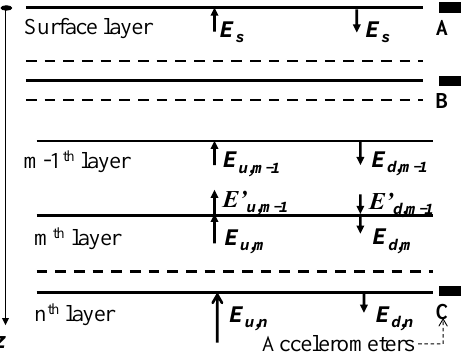
Figure 9. Level ground idealized by a set of horizontal soil layers with vertical array seismometers. Nine earthquakes (Kobe EQ. and EQ1 to EQ8) and 30 vertical array sites used here are listed in Table 1 with associated parameters. They are of the moment magnitude M W = 6.6 to 7.9 or JMA magnitude M J = 6.7 to 8.0 (magnitude in Japan Meteorological Agency scale, similar to Richter scale). A total number of 30 vertical array sites was selected for the nine earthquakes with focal distances ranging from 9 to 227 km. The depth of the vertical arrays from the ground surface to the deepest three-dimensional accelerometer spanned from 83 to 260 m, of which most were nearly 100 m. The S-wave velocities at the base were widely diverged as V s = 380~2800 m/s due to differences in geology, while the surface velocities were mostly V s = 90~430 m/s. Four vertical array sites for Kobe EQ. and one site for EQ7 consisted of accelerometers at three or more different levels including the ground surface, while all others belonging to the KiK-net consisted of only two levels, surface and base. The scalar sum of the wave energies calculated from the two orthogonal horizontal acceleration records were used for the energy flow evaluations. Equivalent linear soil properties S-wave velocity V s and damping ratio D optimized for main shock records were incorporated in the evaluations, wherein D was assumed as non-viscous or frequency independent (Ishihara 1996